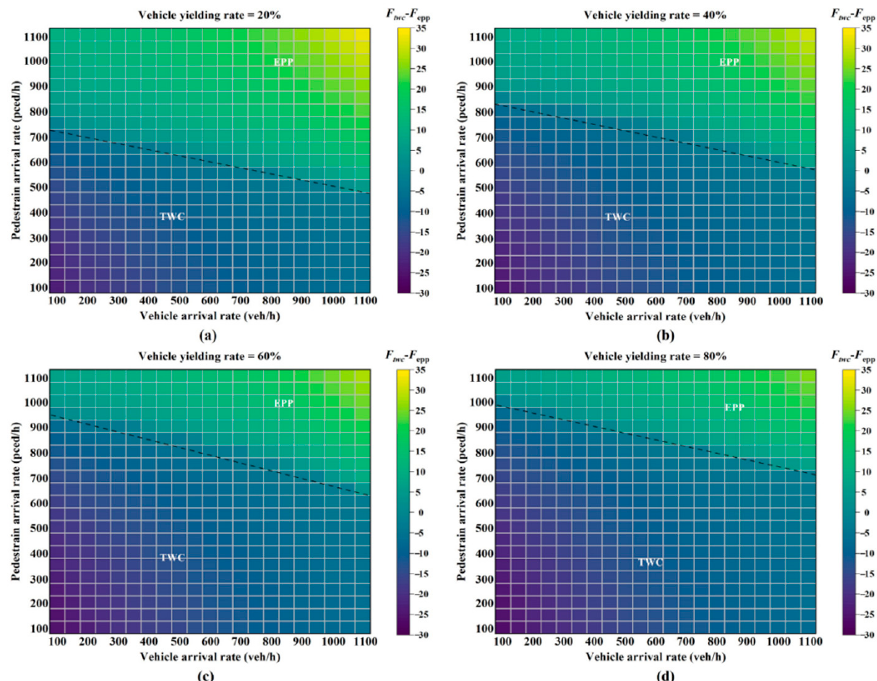
Figure 7. Phase setting and traffic demand under different vehicle yielding rates in the first condition: ( a ) vehicle yielding rate, 20%; ( b ) vehicle yielding rate, 40%; ( c ) vehicle yielding rate, 60%; ( d ) vehicle yielding rate, 80%.